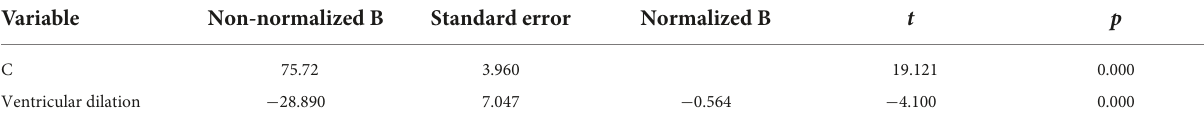
TABLE 2 Multiple linear stepwise regression equation.